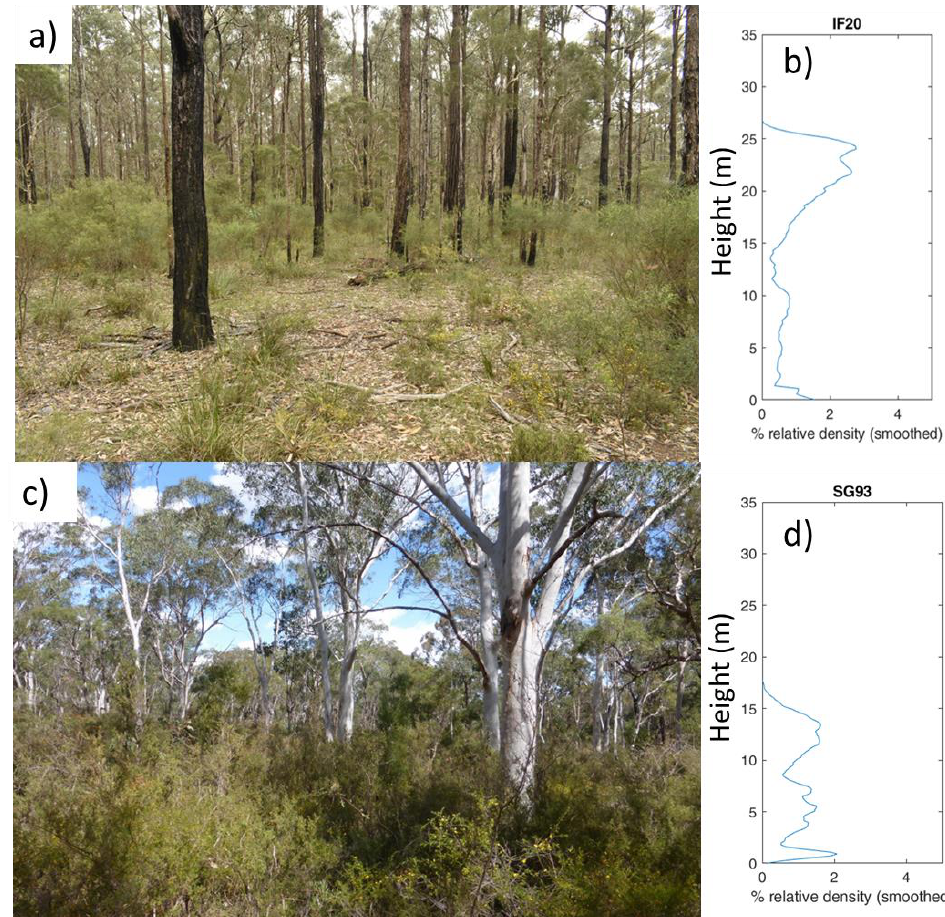
Figure 3. Typical structure of ( a ) Ironbark Forest with ( b ) an example profile of canopy density with height, and ( c ) Scribbly Gum Woodland with ( d ) an example profile of canopy density with height.